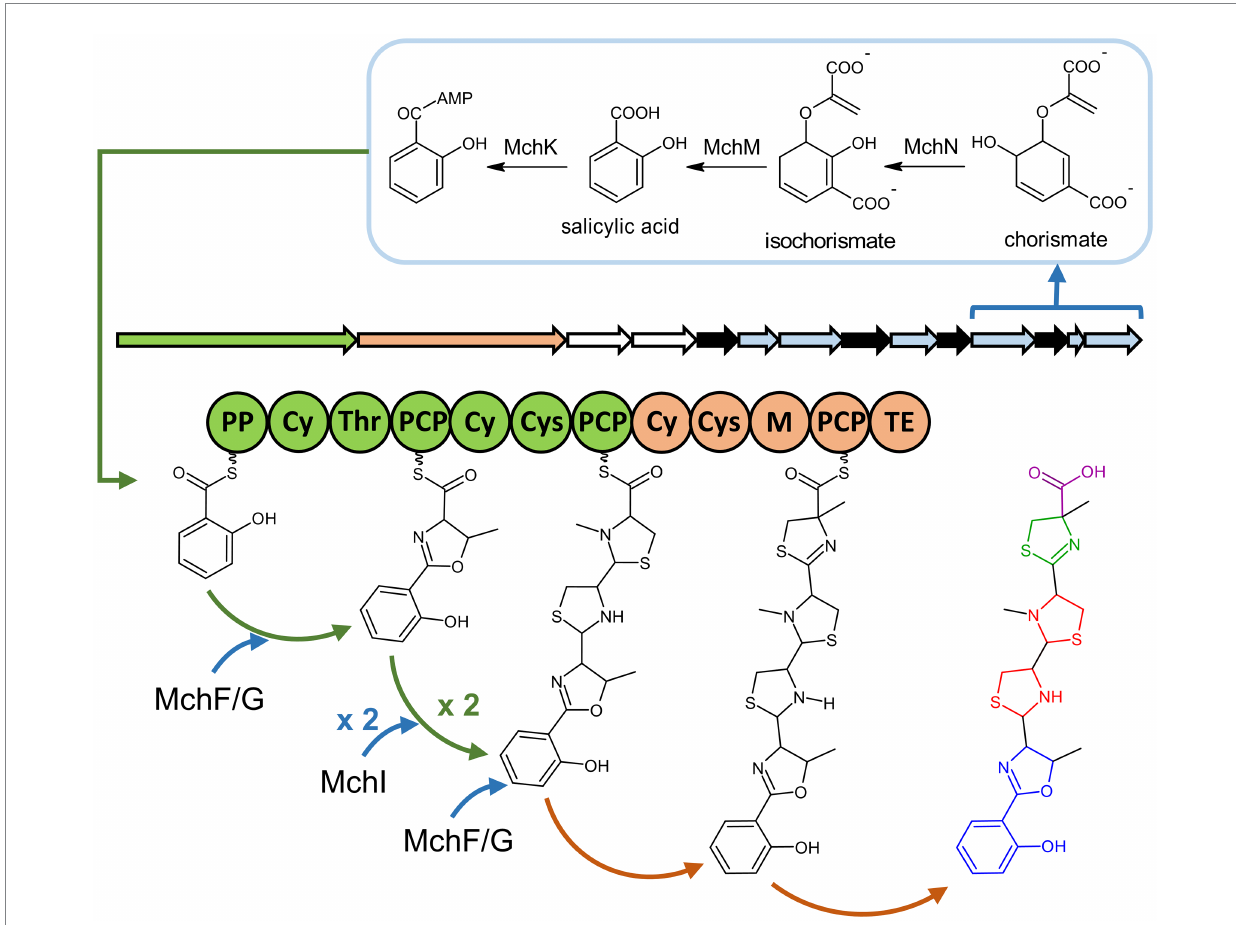
FIGURE 4 Predicted biosynthesis pathway of the mupirochelin siderophore. The first step is the conversion of chorismate to salicylic acid by MchN and MchM enzymes. The compound is then activated by MchK and transferred to the phosphopantheteine-binding domain (PP) of the NRPS enzyme MchA. The first adenylation domain (Thr) is predicted to activate a threonine, which is then condensed, cyclized by the heterocyclization domain (Cy) and transferred to the next peptide carrier protein domain (PCP). N-methylation of the oxazoline ring is predicted to be induced by one of the two SAM- methyltransferase enzymes MchF or MchG. Coupling of a cysteine unit by the second adenylation domain of MchA (Cys) and reduction of the new thiazoline ring formed by the putative thiazolinyl imide reductase MchI are predicted to be iteratively repeated twice. The second SAM- methyltransferase (MchF or MchG) is predicted to be responsible for the methylation of the third unit thiazolidine ring. The final cysteine unit is coupled by the second NRPS enzyme MchB which possesses a methylation domain (M) predicted to realize a C-methylation before release of the compound by the final thioestherase domain (TE). Operon coloring scheme: mchA : green, mchB : orange, transport-related genes: white, function unknown in the biosynthesis pathway: black, additional biosynthetic genes: blue. Mupirochelin coloring scheme: aryloxazoline group: blue, thiazolidine rings: red, thiazoline ring: green, carboxyl group: